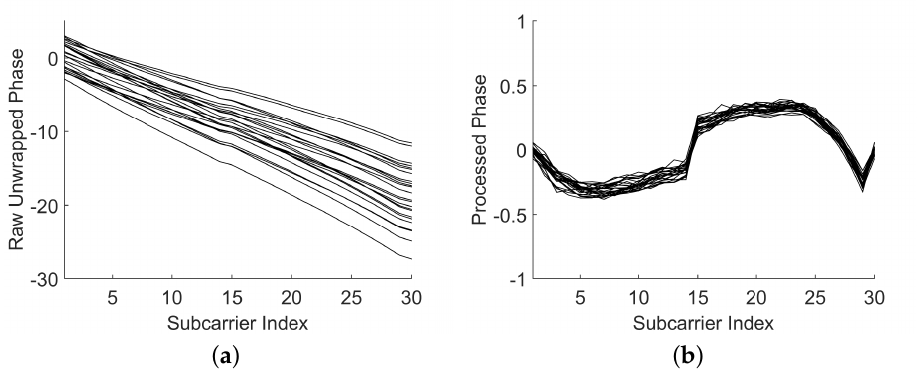
Figure 5. Obtaining a stable phase with 24 packets. ( a ) Raw unwrapped phase. ( b ) Processed